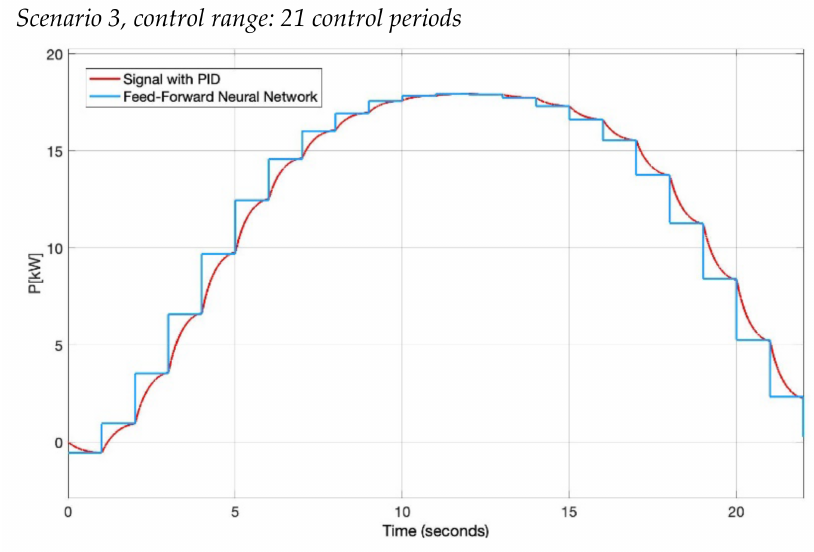
Figure 34. Control signal for BESS 2, p.f. = 1,